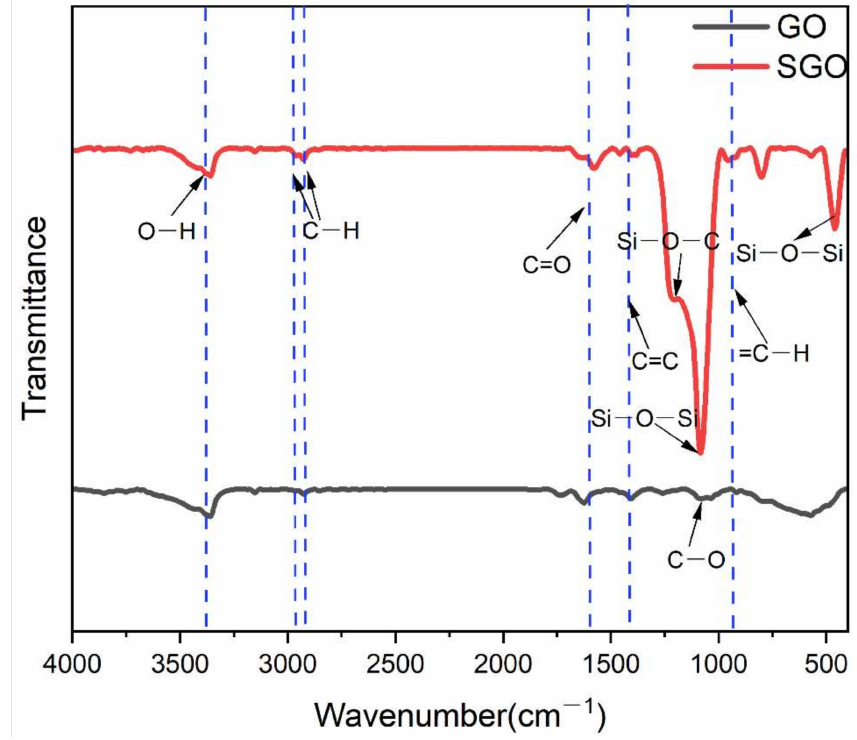
Figure 6. Infrared spectra of GO and SGO.